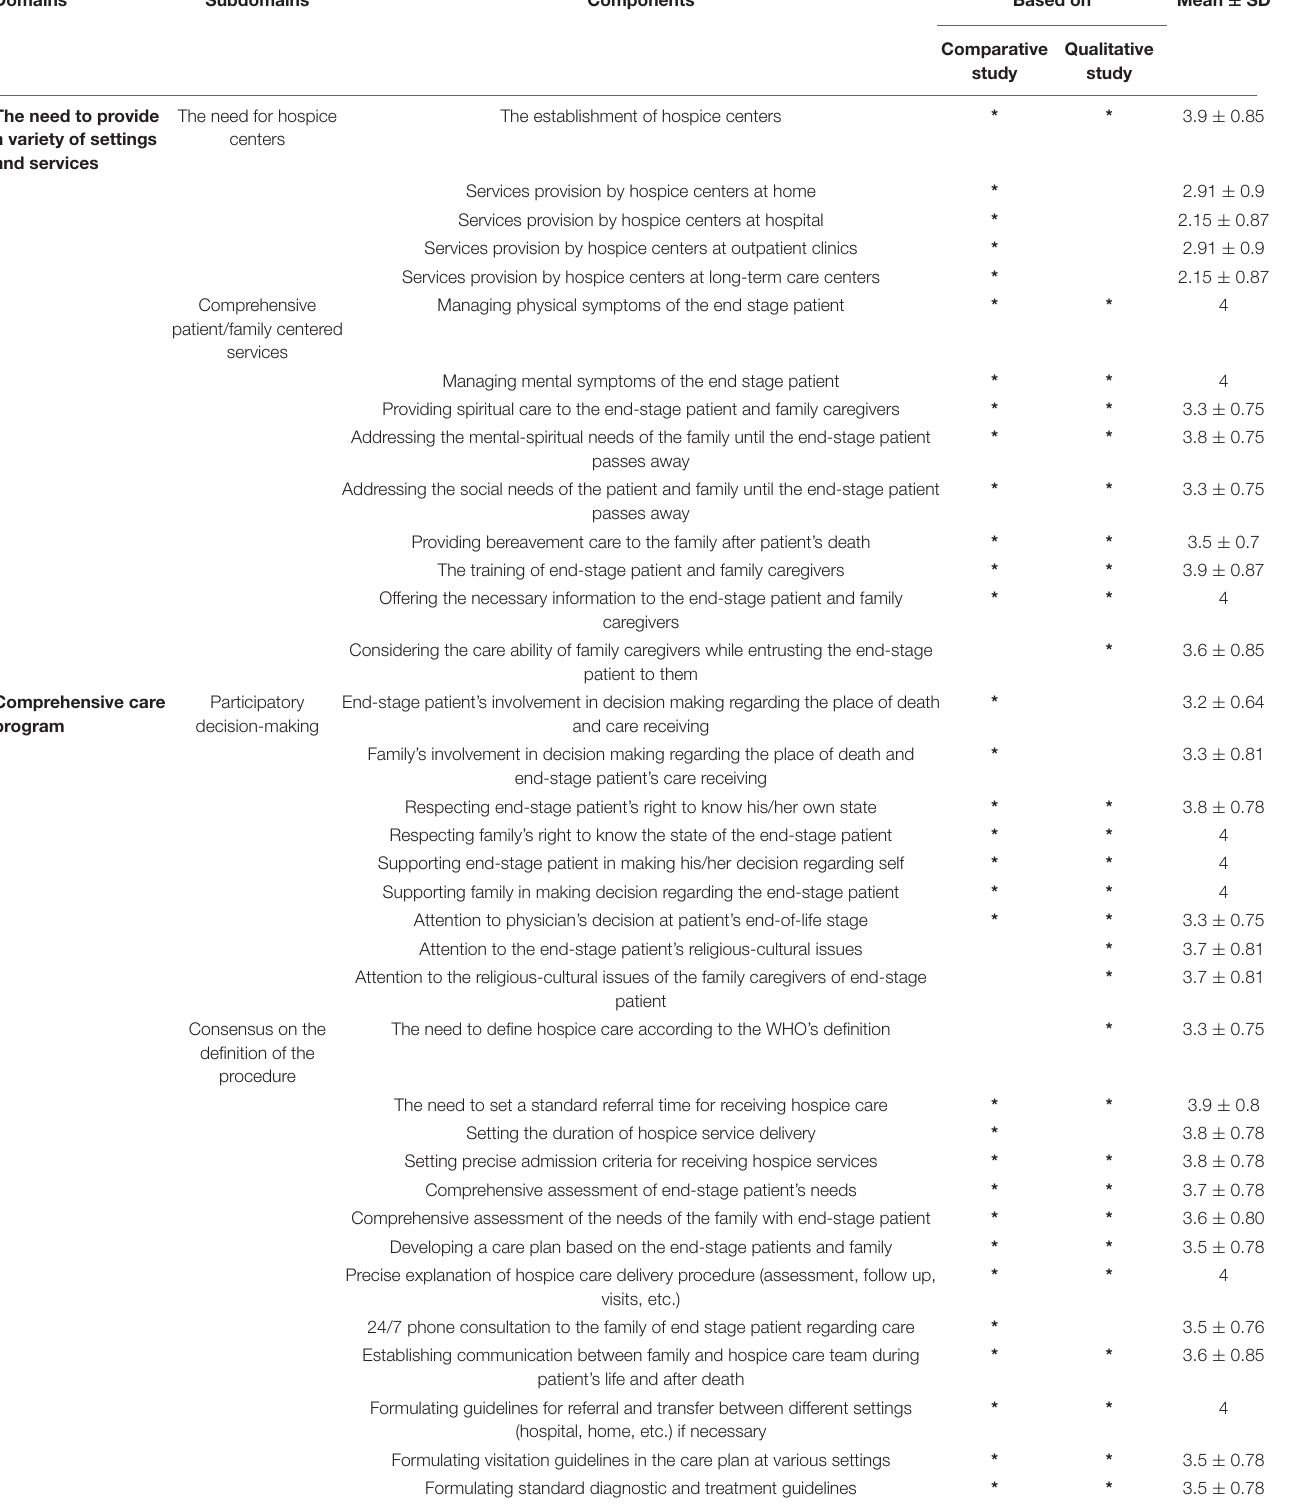
TABLE 2 | The main domains and components extracted from the findings of Phase 1 (comparative study) and Phase 2 (qualitative study) and the mean, minimum and maximum score of components in Phase 3 (minimum mean score = 1, maximum mean score = 4). Domains Subdomains Components Based on Mean ±